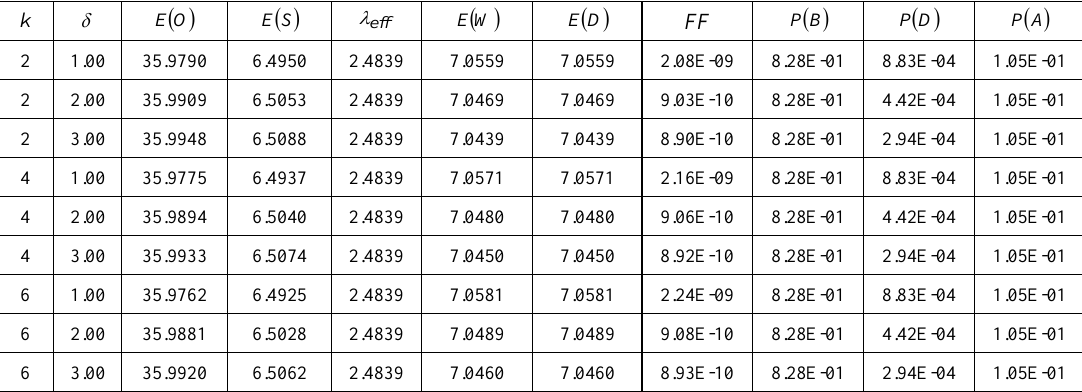
Table 6. Performance measures by varying the number of phases ( ) k and the setup time taken by repairmen ( )  .